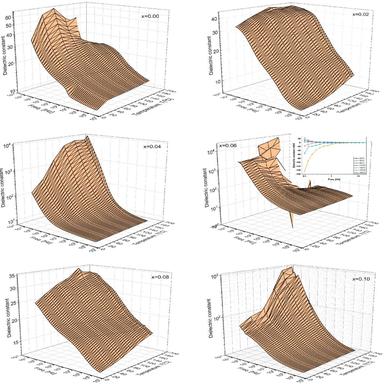
Plots of the dielectric constant of NCZFe2-4xSn3xO4 NSFs as functions of frequency and temperature.